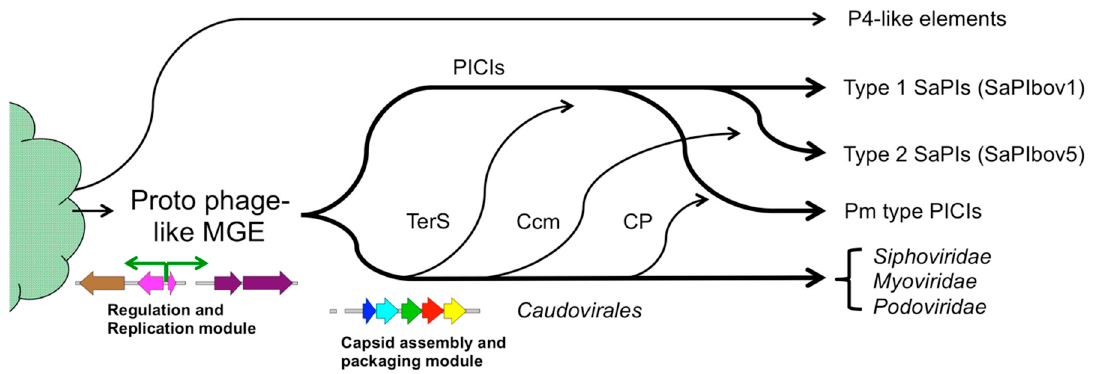
Figure 5. Model for the evolution of molecular piracy by size redirection. The phages and PICIs are ancient elements that originated from a proto-phage and diverged early, separated by the ability of phages to form capsids. The various families of PICIs form separate branches on the evolutionary tree that acquired phage-like functions by horizontal evolution at different times. P4-like elements evolved separately from PICIs from a distinct origin.